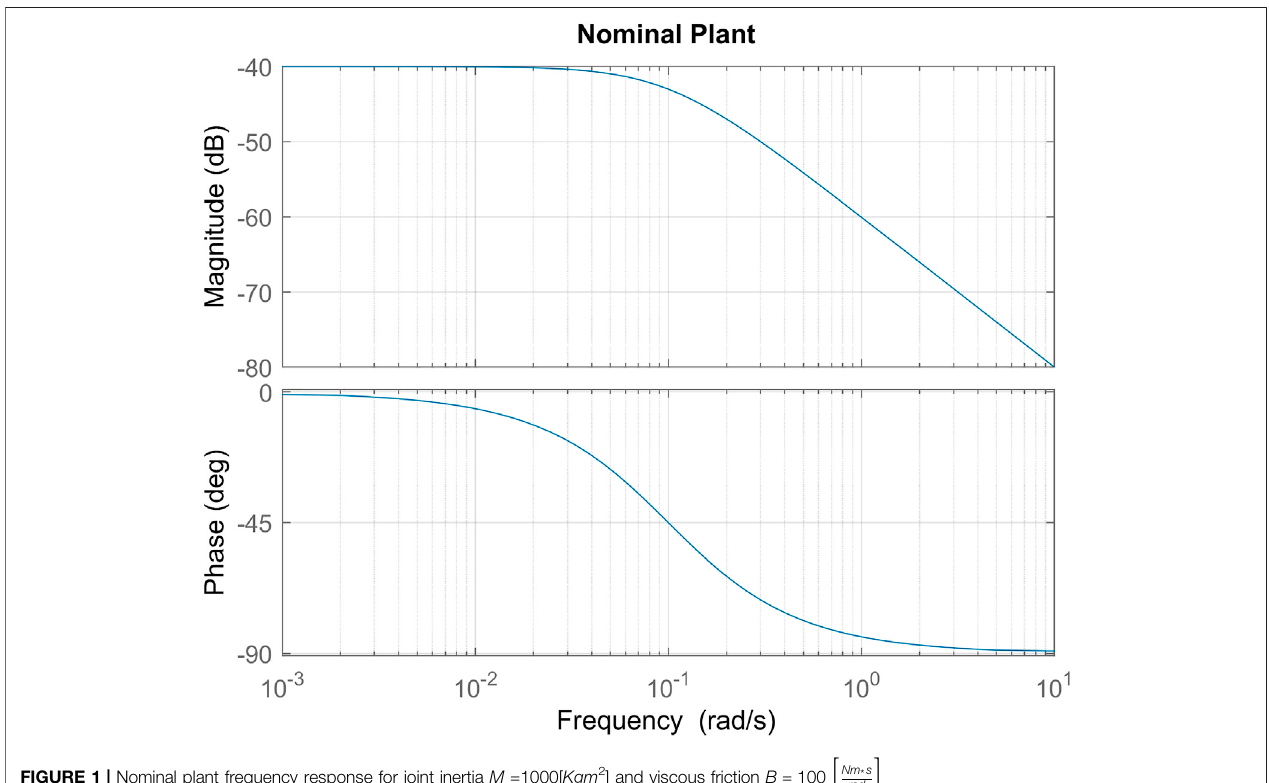
FIGURE 1 | Nominal plant frequency response for joint inertia M (cid:2) 1000[ Kgm 2 ] and viscous friction B (cid:2) 100 (cid:1) Nm * s